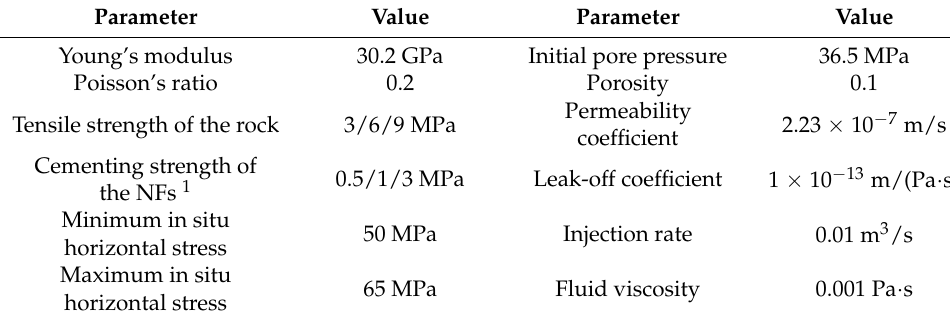
Table 1. Relevant parameters for the